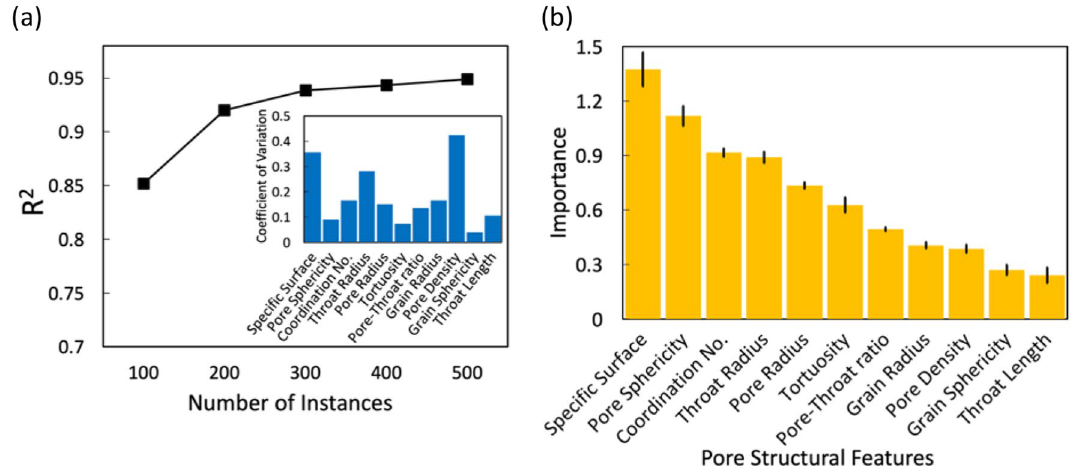
Figure 3. ( a ) The R 2 for importance estimations as a function of the number of instances. Inset: the coefficient of variations of 11 pore structural features; ( b ) the importance ranking of 11 pore structural features estimated by RF model trained with 300 instances. The error bars represent ± standard error which is obtained from fivefold cross-validations.